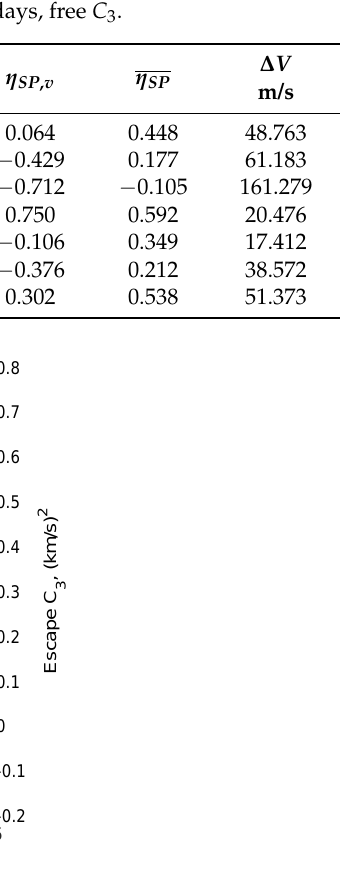
Figure 14. Influence of departure date to escape from EML2—families of solutions—fixed t f = 75 days, free C 3